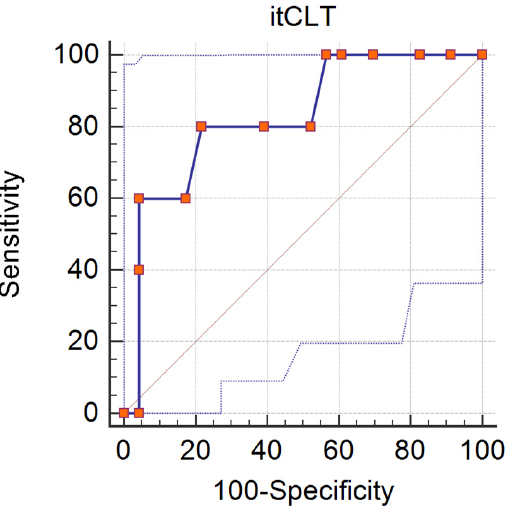
Figure 7. ROC curve for Italian CLT verb comprehension subtest (distinction between lexical risk, n = 5, and no risk, n = 23), AUC = 0.826.